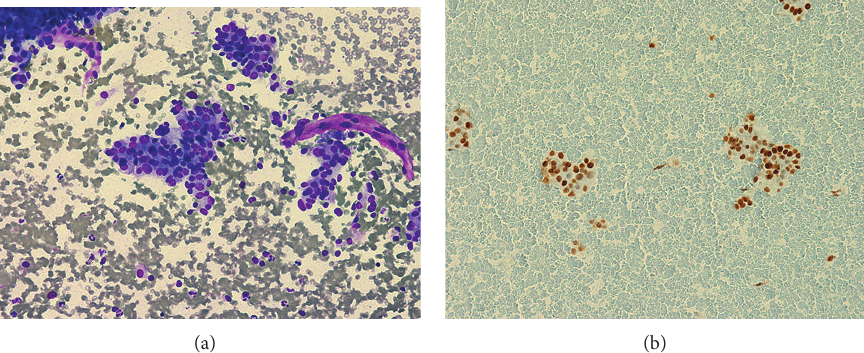
Figure 6: (a) C1 vertebrae biopsy positive for metastatic follicular carcinoma. (b) C1 vertebra biopsy positive for metastatic follicular carcinoma.